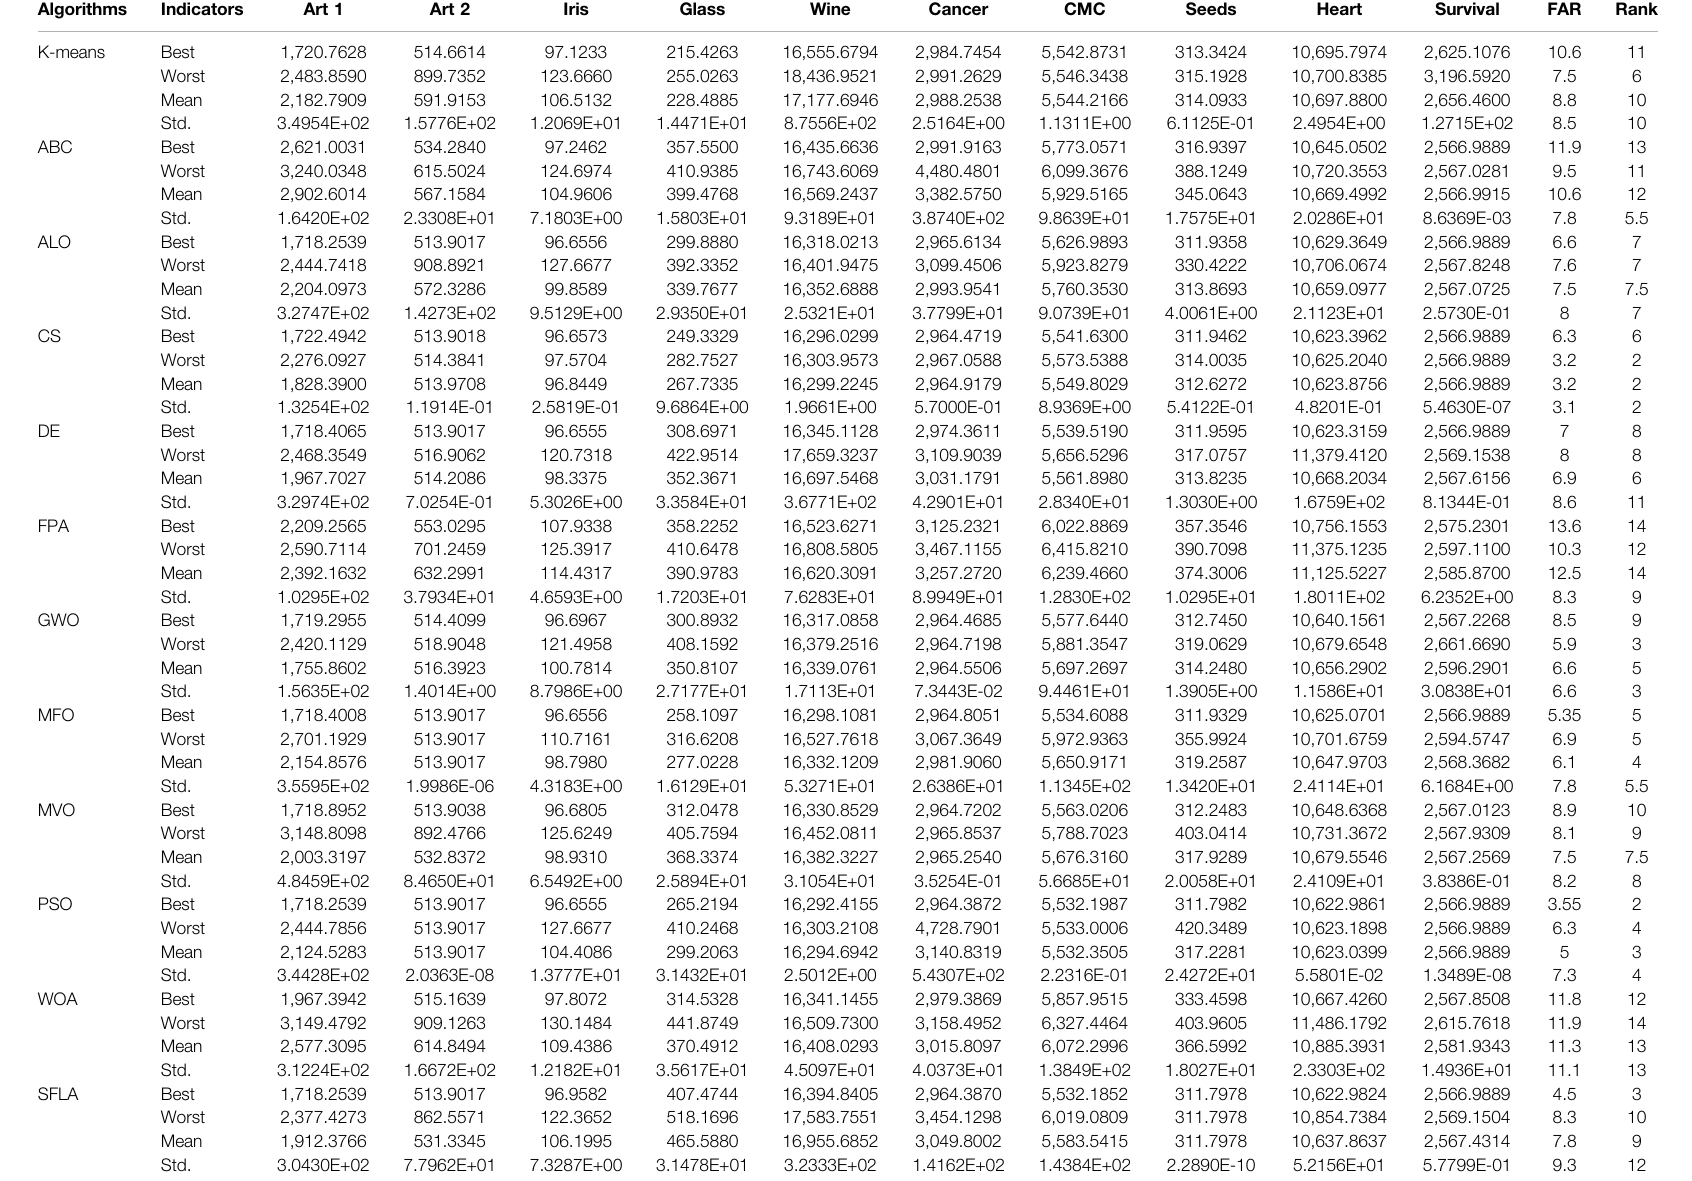
TABLE 3 | Simulation results for clustering algorithm after 20 runs on 10